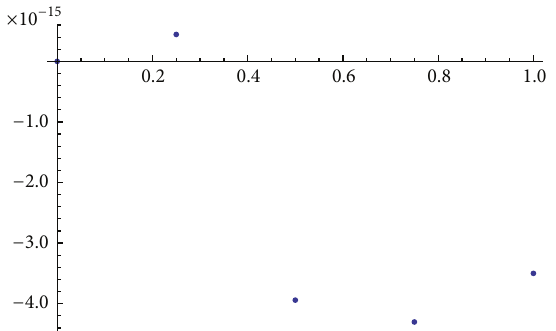
Figure 3: Plot of the absolute error with ℎ = 0.25 , 𝑡 ∈ [0,1] , 𝛽 = 0.1 , 𝜏 = 0.1 exp (−10𝑡)